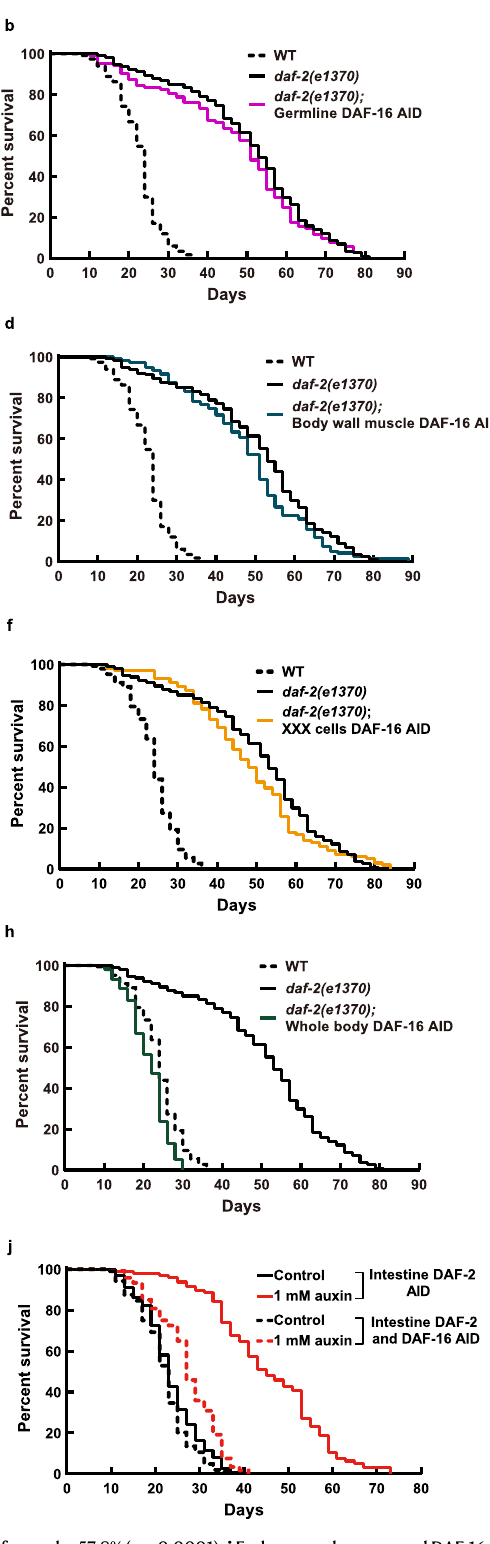
lifespanby57.8%( p <0.0001). i EndogenouslyexpressedDAF-16::GFPaccumulated in the intestinal nuclei upon degrading DAF-2 from the intestine. A similar pattern of expression was observed in three independent experiments. j Degrading intestinal DAF-16 largely suppressed the longevity induced by degrading DAF-2 from the intestine (red dashed line versus red solid line, p <0.0001). p values are calculatedby log-rank tests. See survivalstatistics inSupplementary Data 1.Source data are provided as a Source Data fi